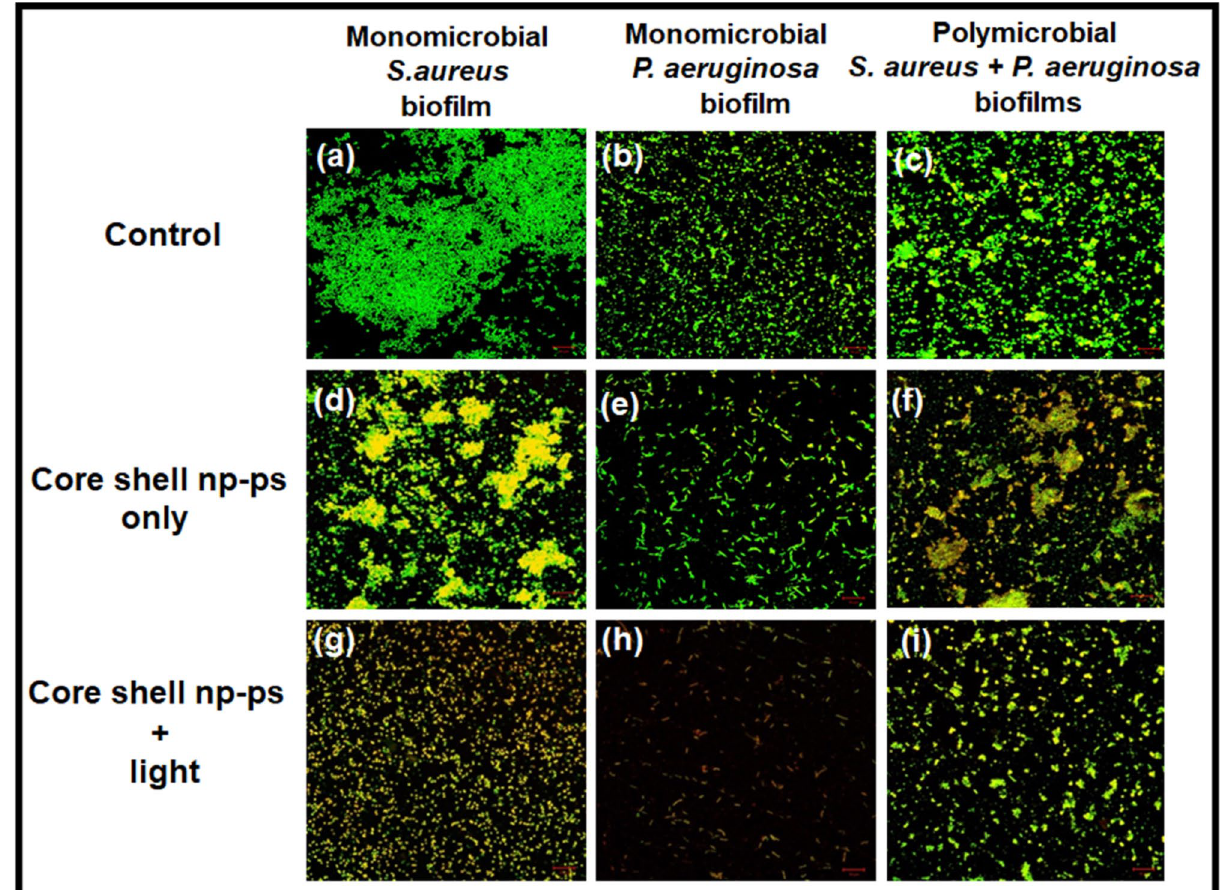
Figure 7. Fluorescence-based live/dead analysis of monomicrobial S. aureus , monomicrobial P. aeruginosa and polymicrobial S. aureus + P. aeruginosa biofilms: Representative fluorescence images of SYTO 9 (live, green) and PI (dead, red) stained bacteria in the groups of control ( a )–( c ), TBO–chit–Au–AgNPstreated ( d )–( f ) and TBO–chit–Au–AgNPs + laser treated ( g )–( i ). 630 nm laser (100 J/cm 2 , 12 min and 50 s) were used in the corresponding laser group. Scale bar = 10